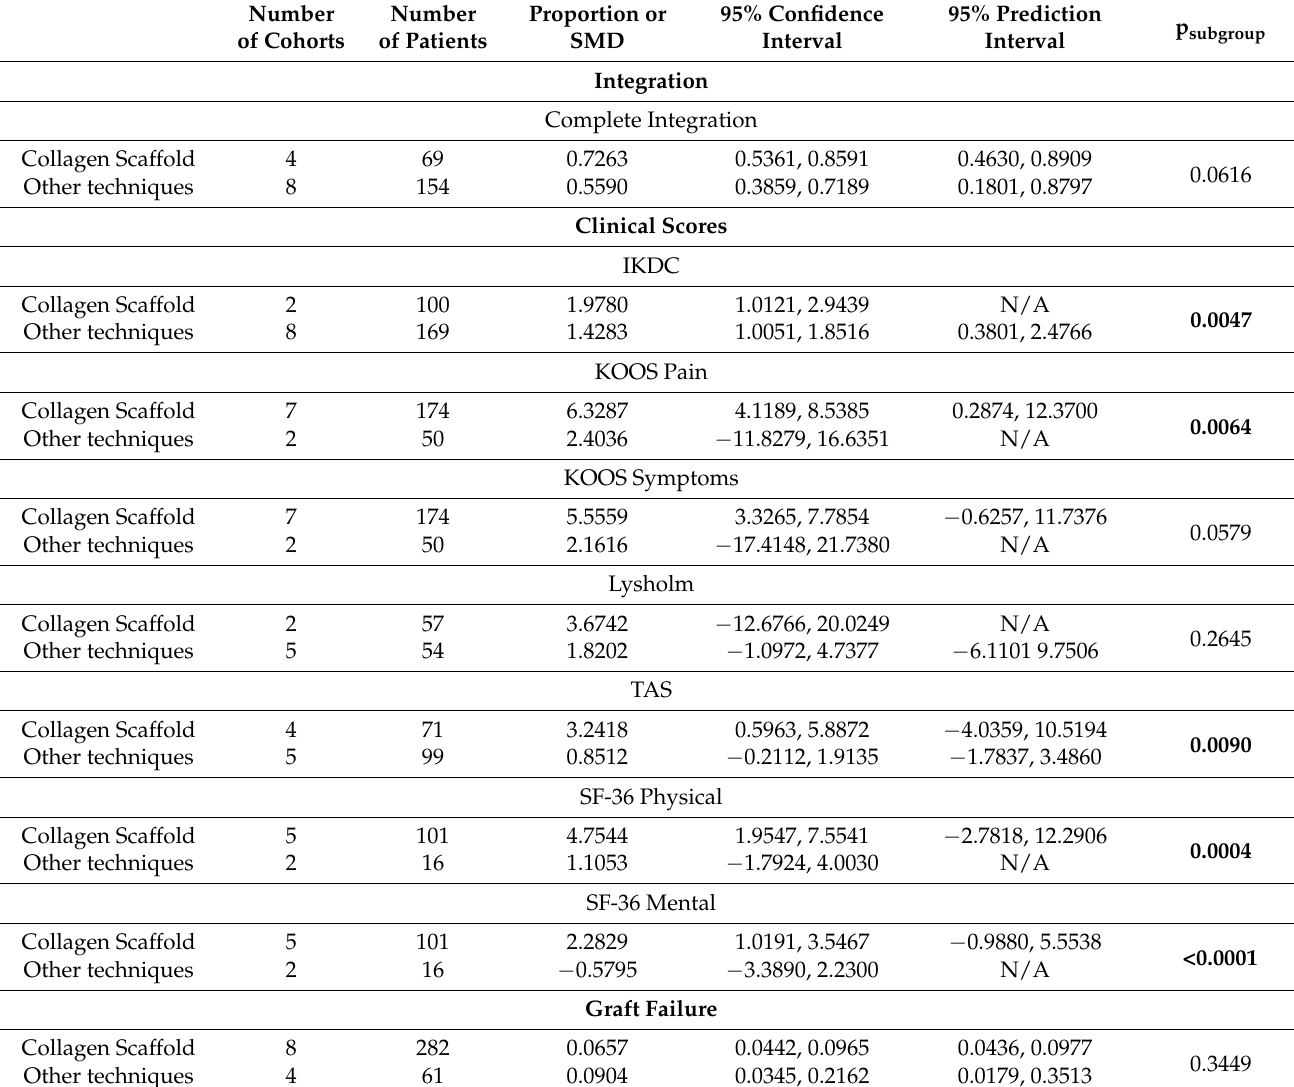
Table 4. Subgroup meta-analyses on the use of collagen as a